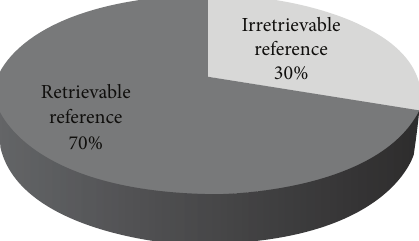
Figure 3: Classification of references as per retrievability